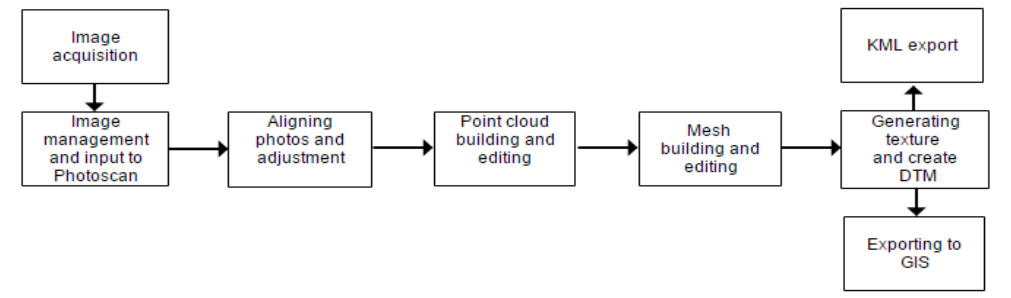
Figure 2. The processing chain of image processing toward DTM in Agisoft.